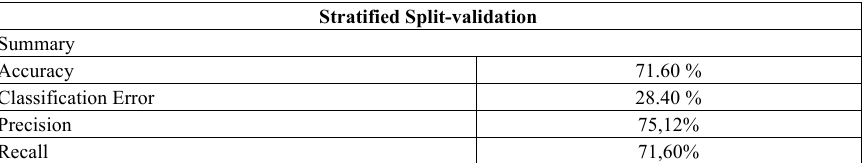
Table 6. Result of